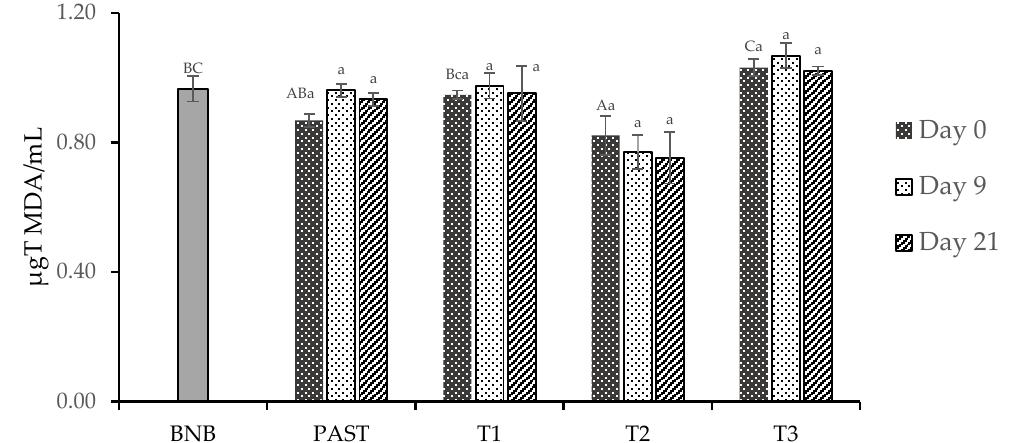
Figure 3. TBA values ( µ gMDA/mL) of the Brazil nut beverage (BNB) treated with HPH (T1, T2, and T3) and pasteurization (PAS) and stored at 5 ◦ C for 21 days. Data were expressed as mean ± standard deviation (n = 3). Different superscript capital letters in-dicate statistically significant differences ( p ≤ 0.05) between treatments in day 0. Different super-script lower-case letters indicate statistically significant differences ( p ≤ 0.05) between days of cold storage within the same